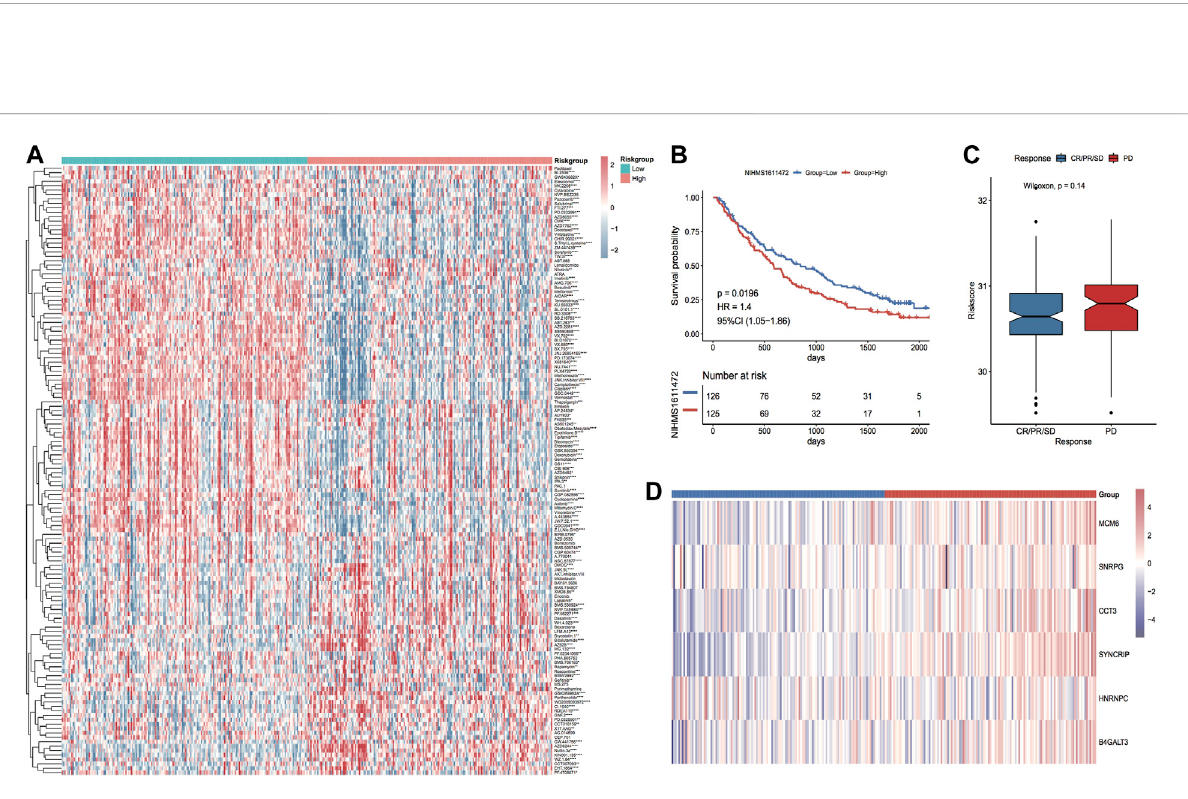
FIGURE 15 Differencesindrug sensitivitybetweenmodelsubgroups. (A) Thermographic ofIC50 values between high andlow-risk subgroups intheTCGA LIHC cohort, red highlights high drug sensitivity and blue highlights low sensitivity; (B) KM curves in the immunotherapy cohort; (C) Box plot of risk score distribution between immunotherapy response subgroups in the immunotherapy cohort, red highlights non-response group and blue highlights response group; (D) Thermographic of the expression distribution of model genes in the immunotherapy